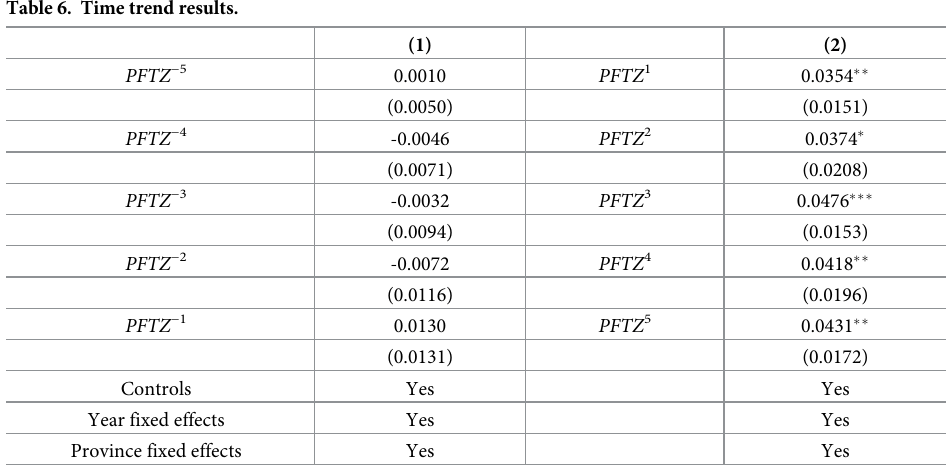
Table 6. Time trend